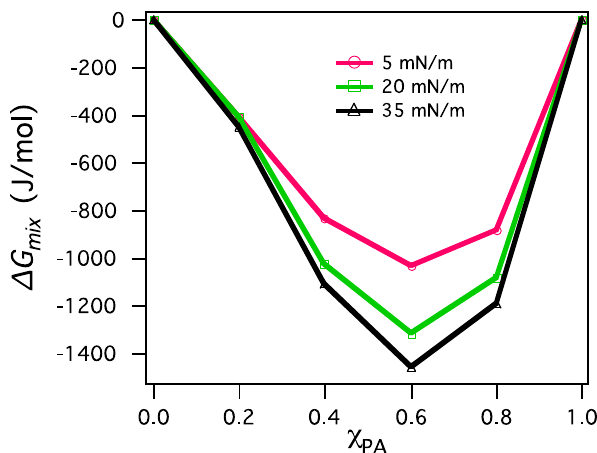
Figure 8. Free energies of mixing of PA/cerebrosides mixtures as a function of PA chemical composition at various surface pressures.